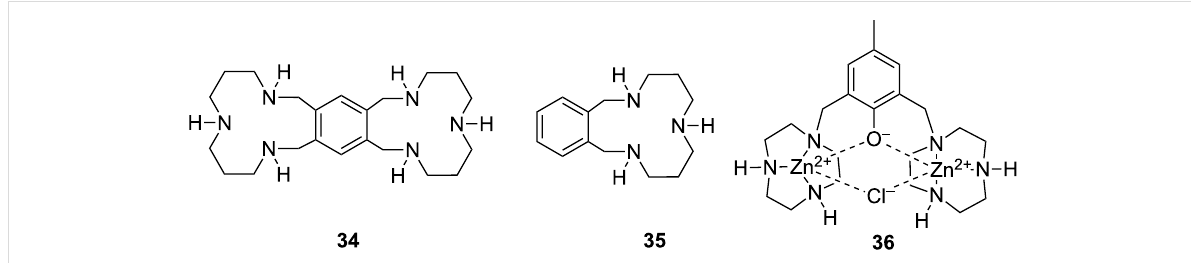
Figure 13: Azacrown ligands 34 and 35 and dinuclear Zn 2+ complex 36 used in kinetic studies of metal-ion-promoted cleavage of nucleic acids.